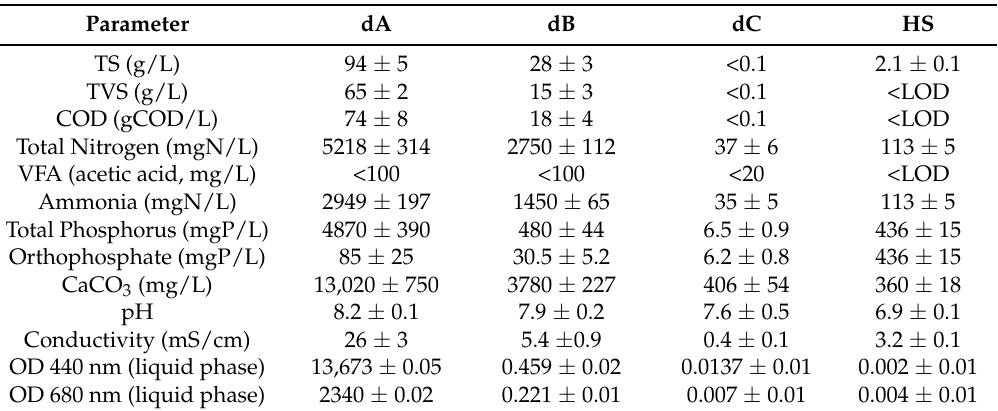
Table 1. Composition of selected